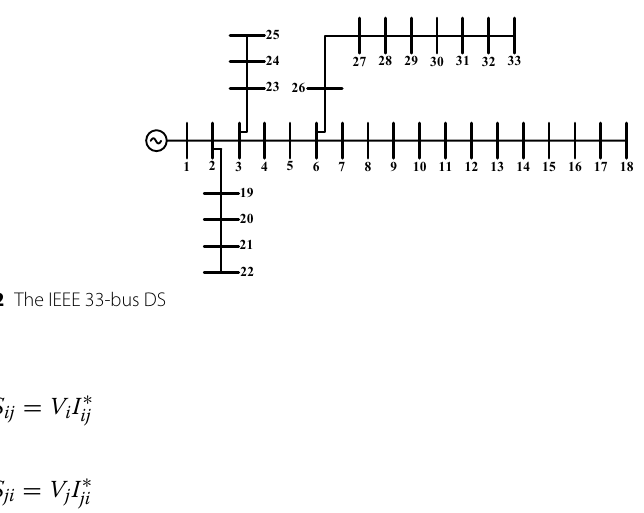
Fig. 2 The IEEE 33-bus